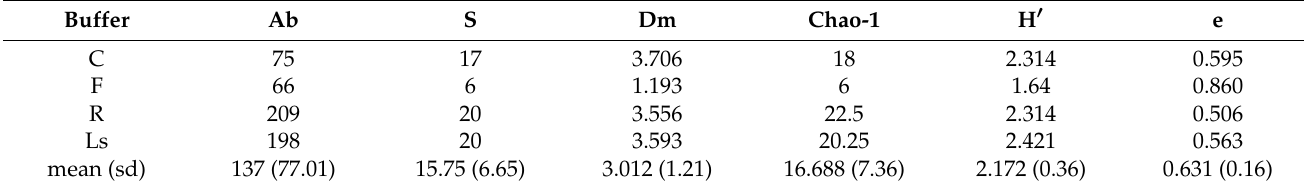
Table 1. Univariate metrics of diversity for the studied wetland-related bird communities (Ab, total abundance index; S, species richness; Dm, normalized species richness (Margalef index); Chao-1, Chao-1 richness estimator; H (cid:48) , Shannon-Wiener diversity index; e, evenness. Buffer area: C, Com- mando; F, Fula; R, Rai; Ls, Landing site; Nimule National park: L, Lobubu; Si2, Simo 2; Si1, Simo 1; Apalla, Apalla; Iria, Iria. *: p <